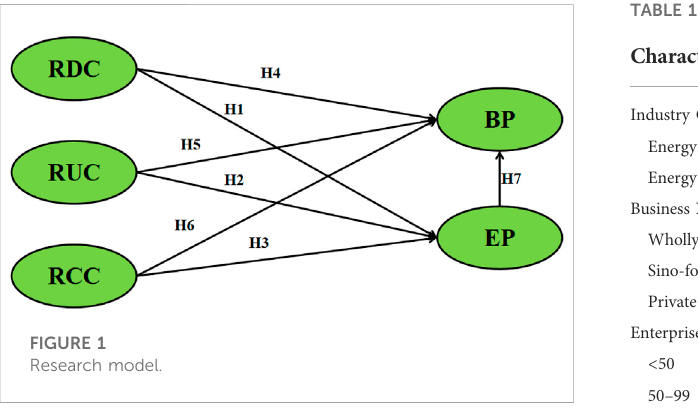
TABLE 1 Distribution of sample characteristics